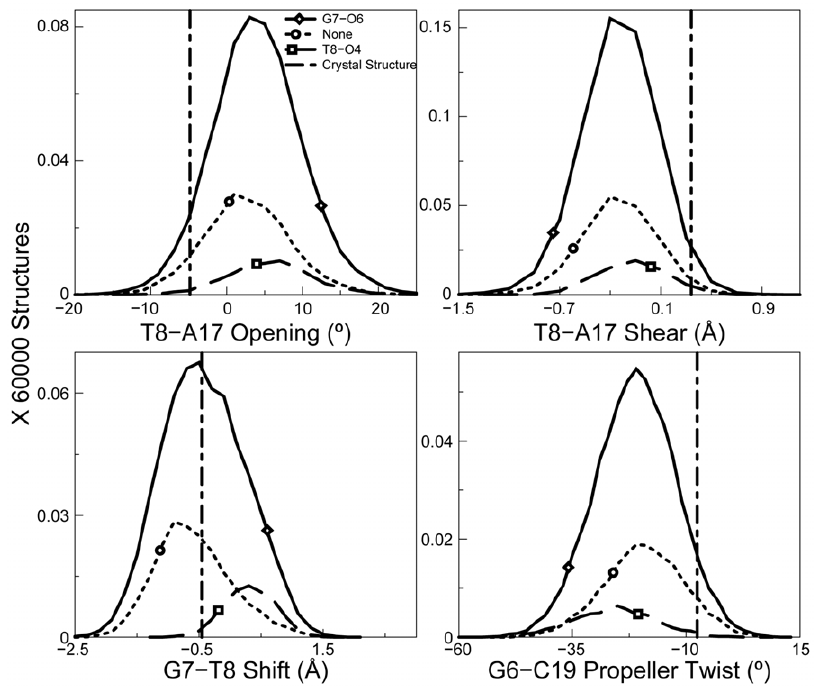
Figure 9. Helical parameters in the OX-TGGT sequence context. Four helical parameters plotted as a histogram showing the most significant differences for different hydrogen bonded species of the OX-DNA adduct are shown. The frequency distributions were calculated in a manner identical to that described in Figure 8. The distribution for structures with no hydrogen bond is plotted in dotted lines, for structures with G7-O6 hydrogen bond plotted with a solid line and structures with T8-O4 hydrogen bond, is plotted in dashed line. The bend angle of DNA in the crystal structure of CP-DNA bound to HMGB1a is plotted as a vertical dashed line.